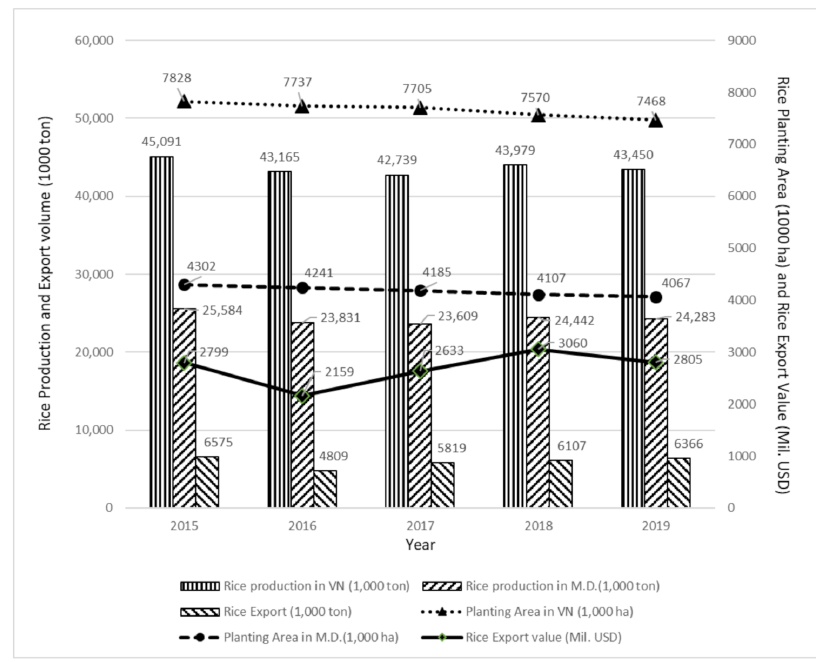
Figure 18. Transition of rice planting area, rice production volume, and rice export volume and value from 2015 to 2019. Rice production in Vietnam and the Mekong Delta is paddy rice volume, and rice export is milled rice volume.; Source: created from GSO and Vietnam Customs data [39,40].